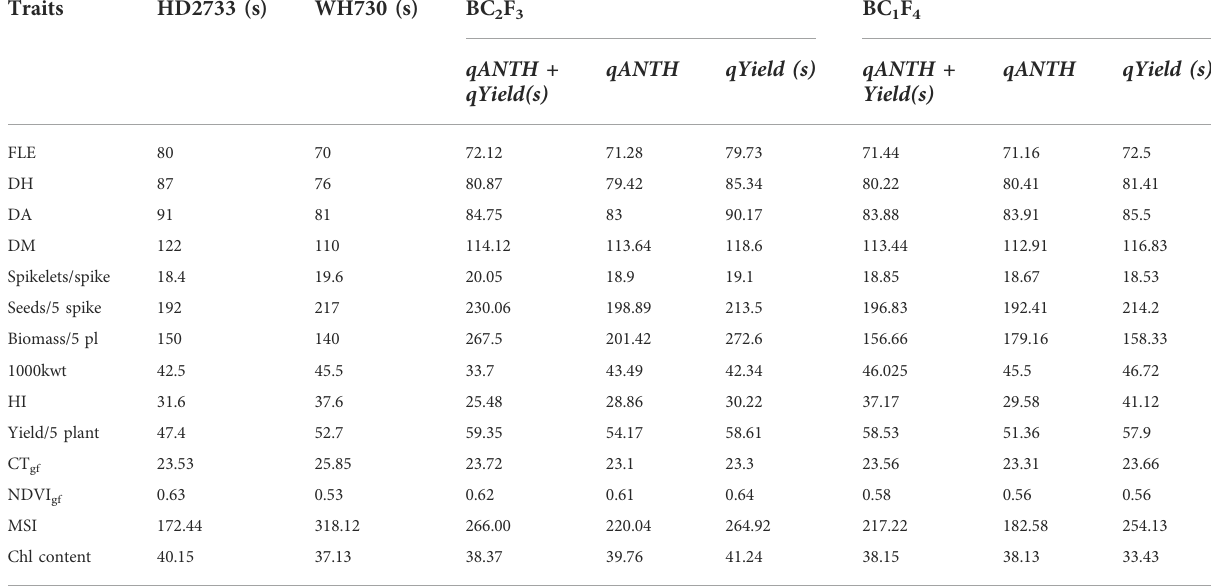
TABLE 5 Morpho-physiological characters of parents and selected MABB-derived lines with single and two QTLs.